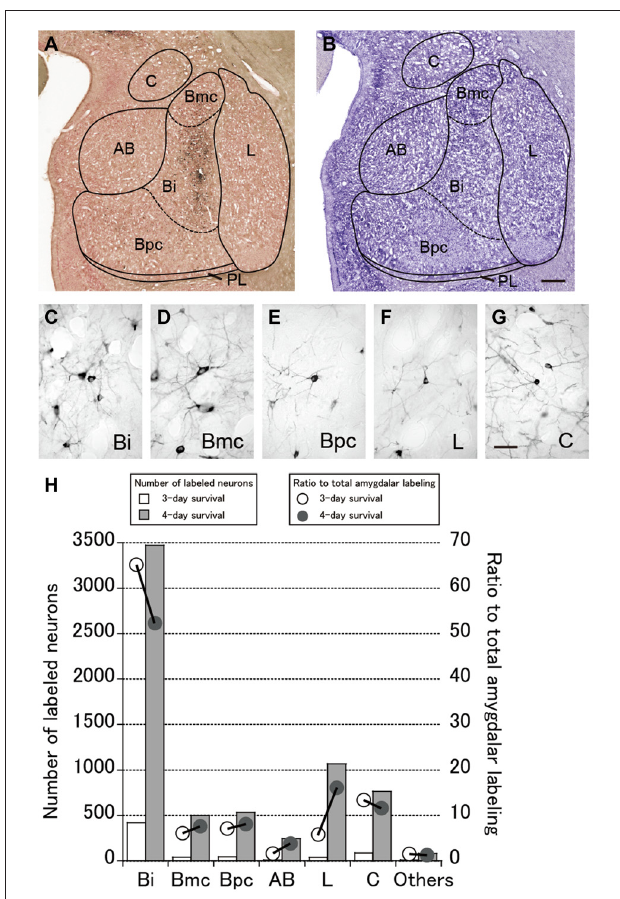
FIGURE 3 | (A) Low-magnification photomicrograph of a representative coronal section through the amygdala in Case 3 in which the monkey was sacrificed 4 days after the rabies injections into PMv. (B) Nissl-stained section adjacent to the section in (A) . AB, accessory basal nucleus; Bi, intermediate division of the basal nucleus; Bmc, magnocellular division of the basal nucleus; Bpc, parvocellular division of the basal nucleus; C, central nucleus; L, lateral nucleus; PL; paralaminar nucleus. Scale bar in (B) , 1 mm for both panels. (C–G) Examples of labeled neurons in the amygdalar subnuclei. Scale bar in (G) , 50 µ m for all panels. (H) Summary histograms showing the number (squares) and ratio (circles) of labeled neurons at the 3-day (open symbols) and 4-day (filled symbols) survival periods. The mean values in each subnucleus are indicated.